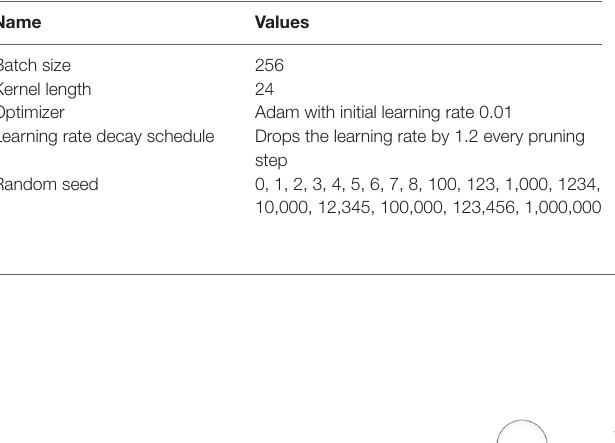
TABLE 1 | Parameter settings for the simulated datasets.